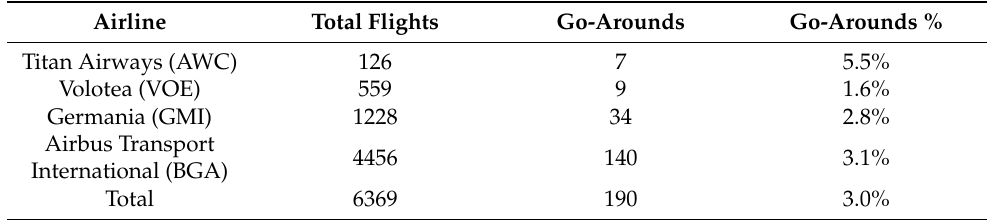
Airline Total Flights Go-Arounds Go-Arounds %